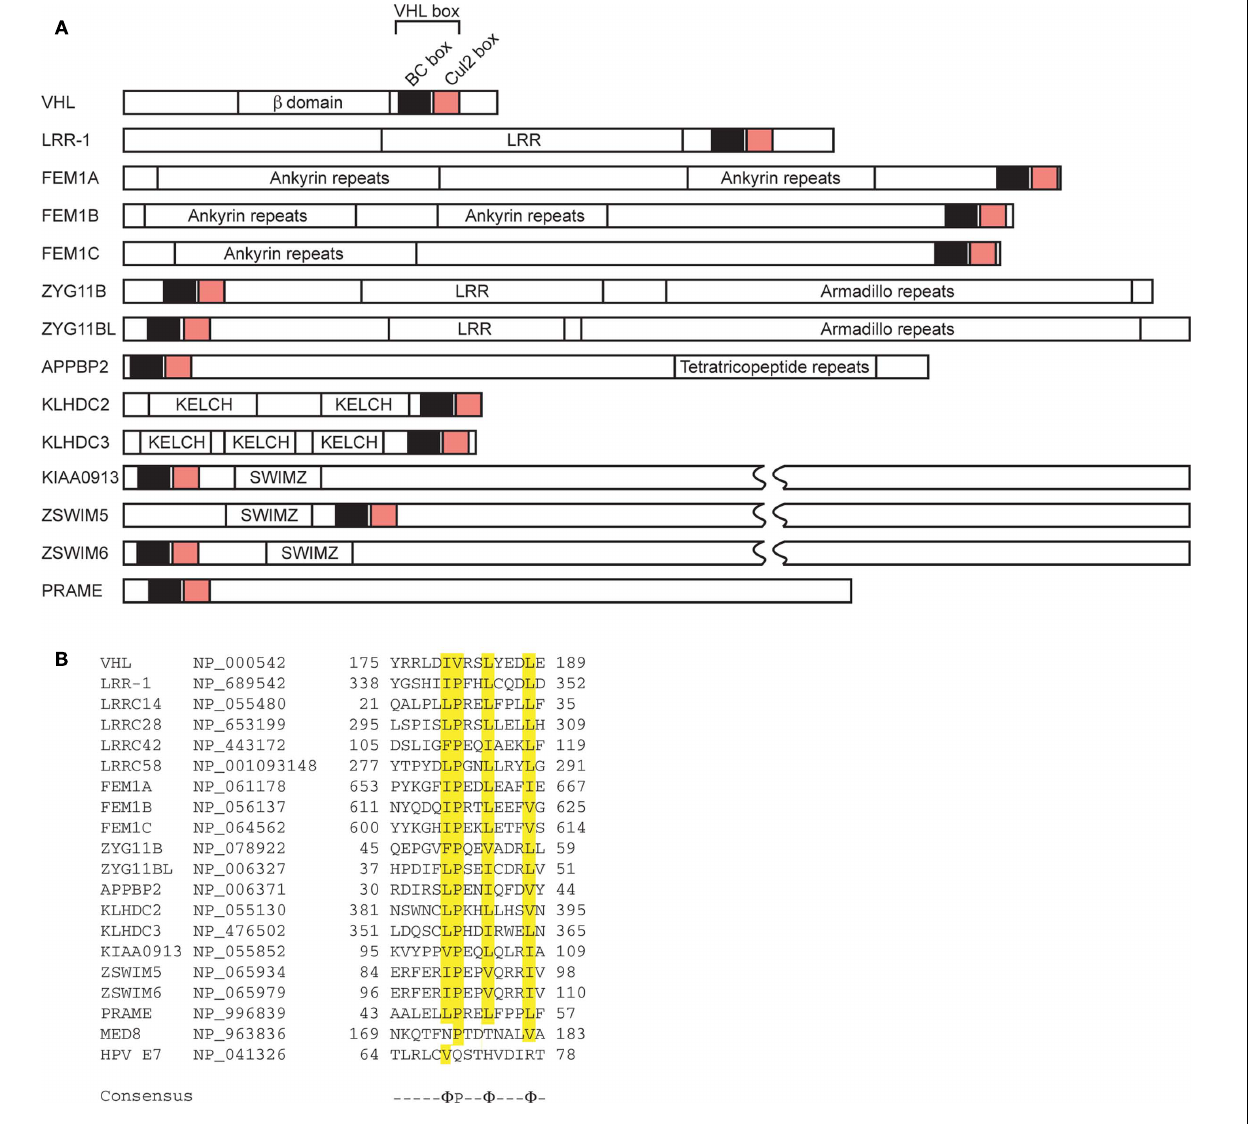
sequences of selected Cul2 boxes. Identical amino acids are highlighted in yellow. GenBank™accession numbers of each protein are indicated.The consensus sequence is indicated below. Φ , hydrophobic